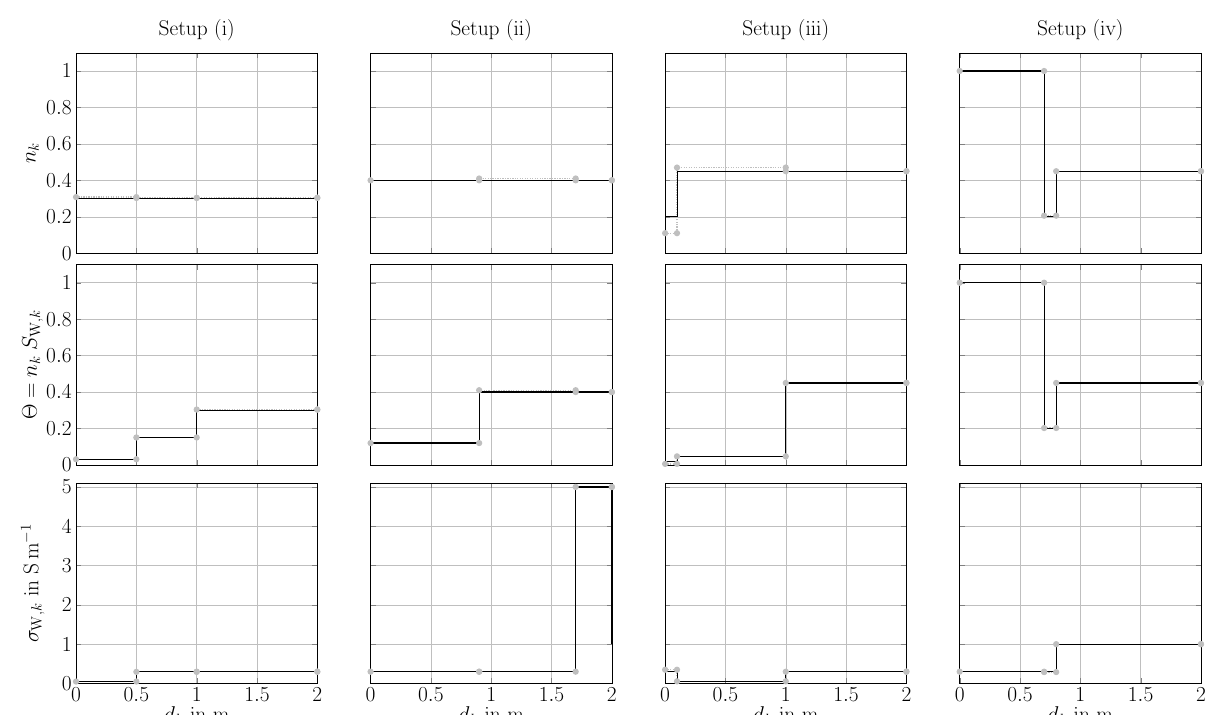
Figure A1. Comparison of the modeled ( ) and retrieved layer properties ( ) for all four